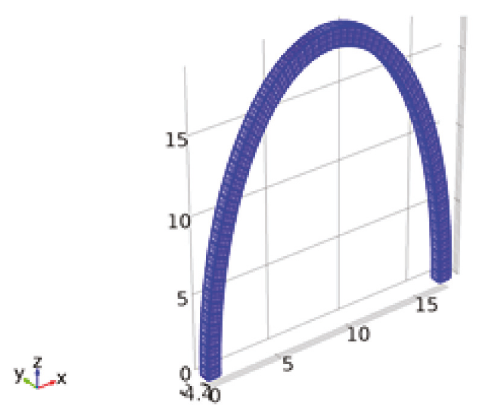
Figure 4: Ringstone meshing and meshing